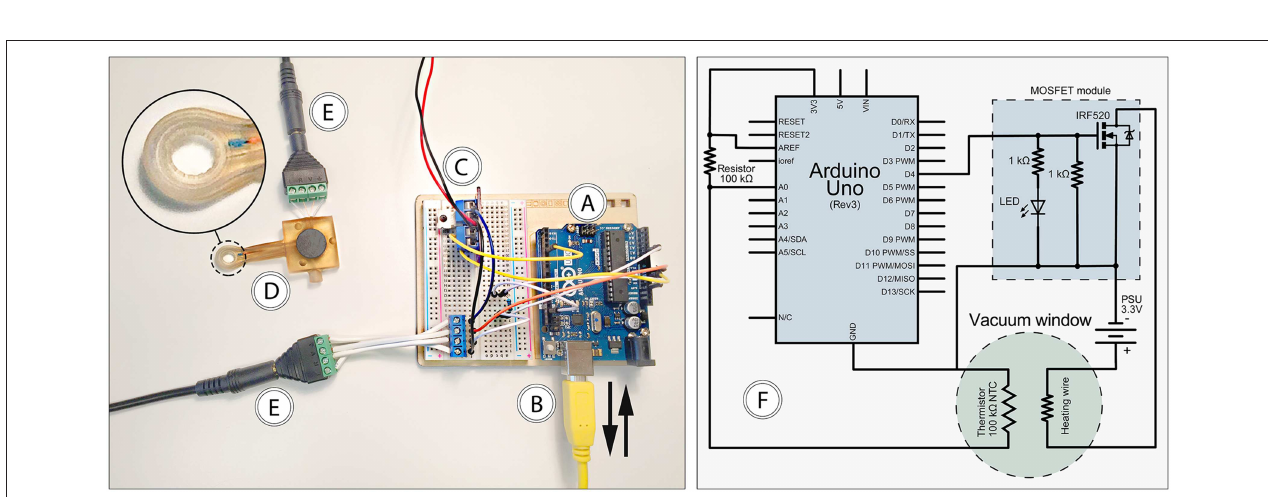
FIGURE 3 | Features of the electronic control unit. (A) Arduino Uno, (B) USB connection to computer, (C) 3.3V power supply and MOSFET module, (D) vacuum window, (E) 4-wire cable, (F) circuit